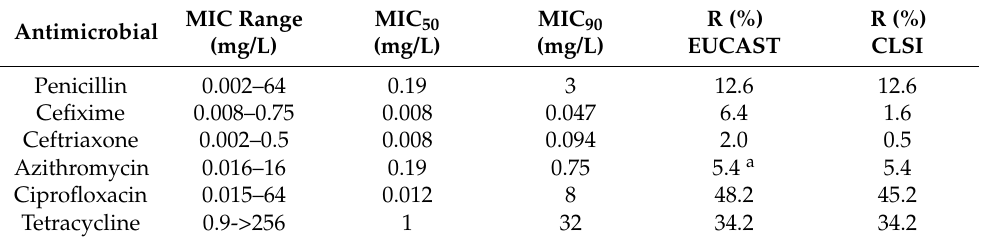
Table 2. Antimicrobial susceptibility of 202 N. gonorrhoeae isolates collected in 2017–2019 ( n = 202).